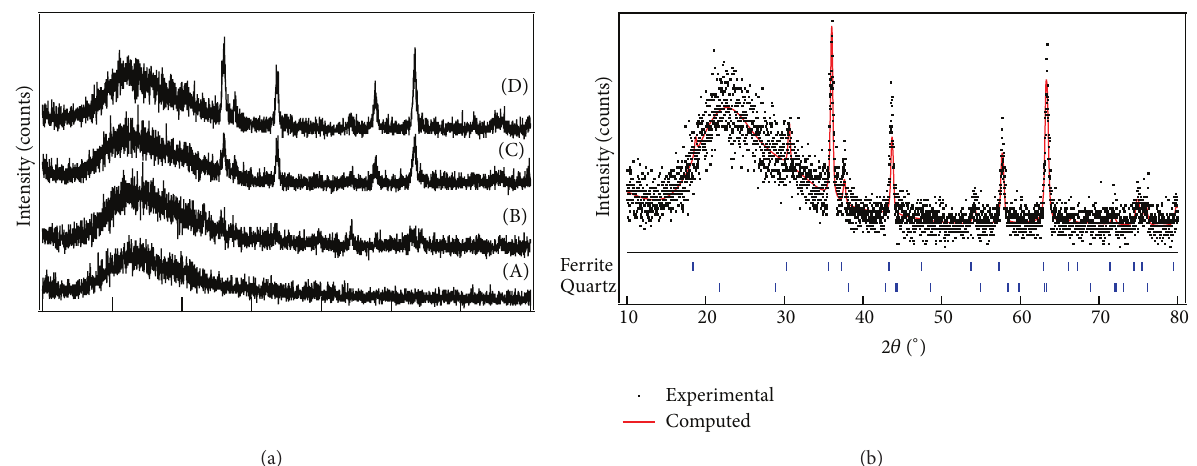
Figure 2: X-ray diffractograms of silica coated nickel ferrite at (a) various calcination temperatures and (b) Rietveld refinement of sample D.